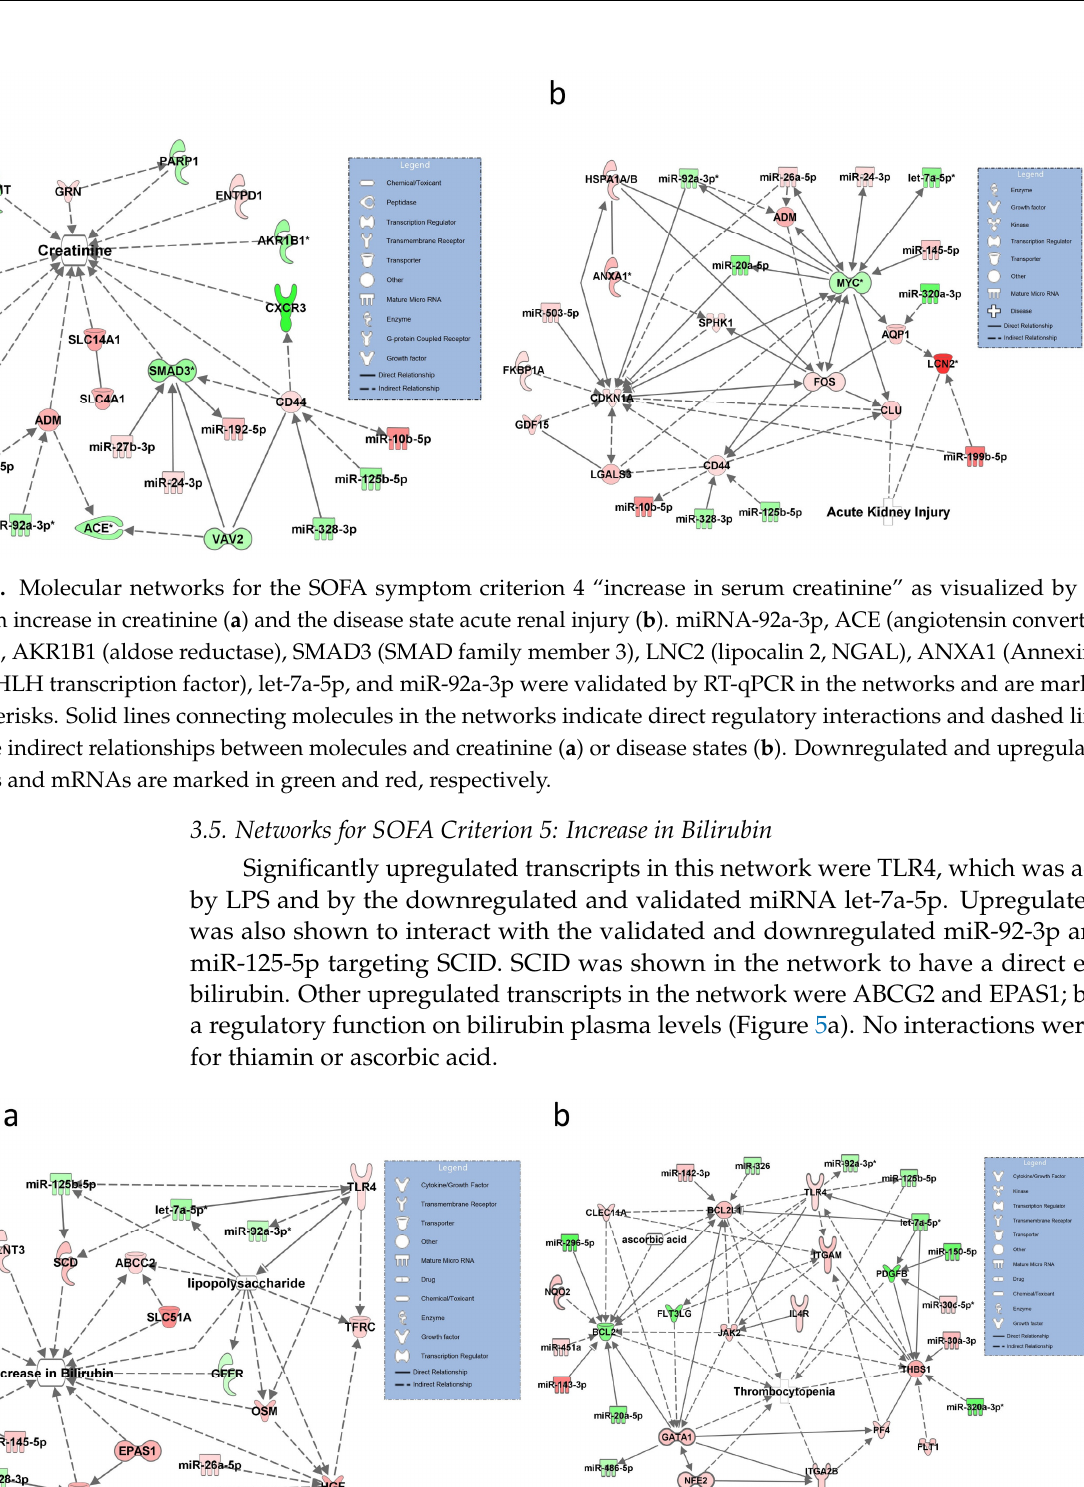
7 of 12 Figure 3. Molecular network for SOFA symptom criterion 3 “circulatory failure”, represented by the disease state sepsis associated hypotension and the network cardiovascular signaling in sepsis. let-7a-5p, miR-30c-5p, miR-486-5p, miR-92a- 3p, BCL2 (BCL2 apoptosis regulator), MYC (bHLH transcription factor), PPARG (peroxisome proliferator-activated recep- tor gamma), SMAD3 (SMAD family member 3), and TP53 (transformation related protein 53) were RT-qPCR validated and are marked with an asterisk. Possible target molecules of the two vasopressors norepinephrine and angiotensin II are shown along with transcripts associated with increased lactate levels (s. text). Downregulated and upregulated miRNAs and mRNAs are marked green and red, respectively. Solid lines connecting molecules indicate direct regulatory interac- tions and dashed lines indirect relationships between molecules in the network. 3.4. Networks for SOFA Criterion 4: Increase in Serum Creatinine For this criterion, two networks were constructed with the disease status set at in- crease in serum creatinine (Figure 4a) and acute renal injury in sepsis (AKI) (Figure 4b). In the first network, molecules in the pathway showing an association with serum creati- nine included ACE (validated), interacting with upregulated ADM and regulated by miR- 92a-3p and SMAD3 (validated) and targeted by miR-24-3p, miR-192-5p, and miR-27p-3p. AKR1B1 (validated) and KL were also related to creatinine levels (Figure 4a). The second